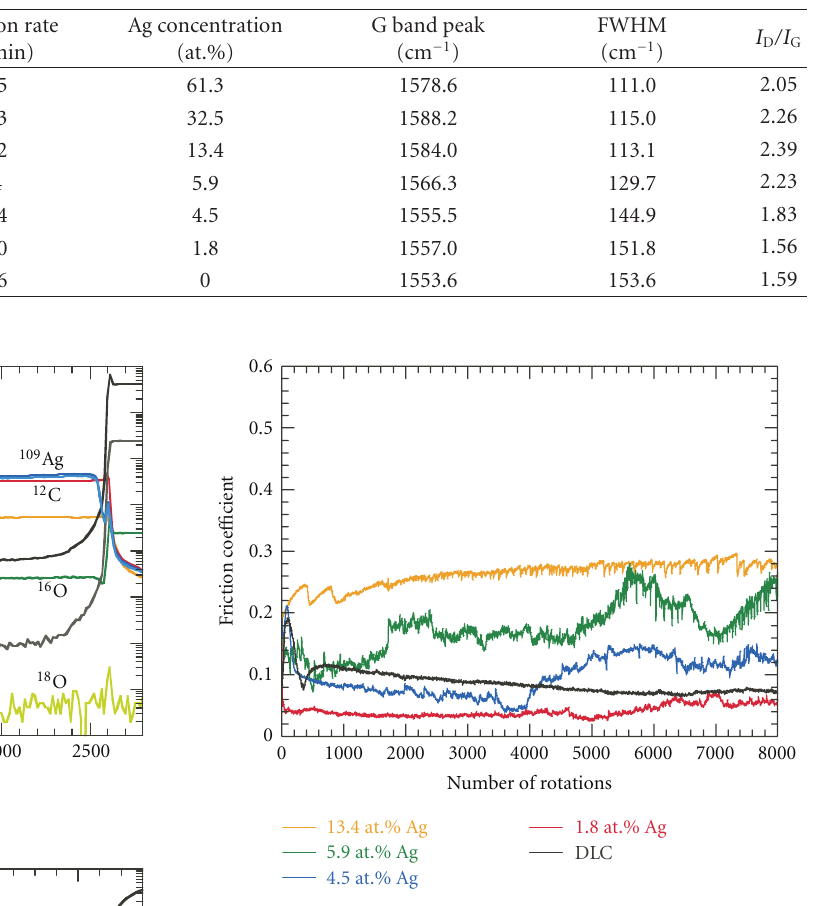
Figure 5: Friction coe ffi cient as a function of rotations in the ball- on-disk tests of silver-containing DLC